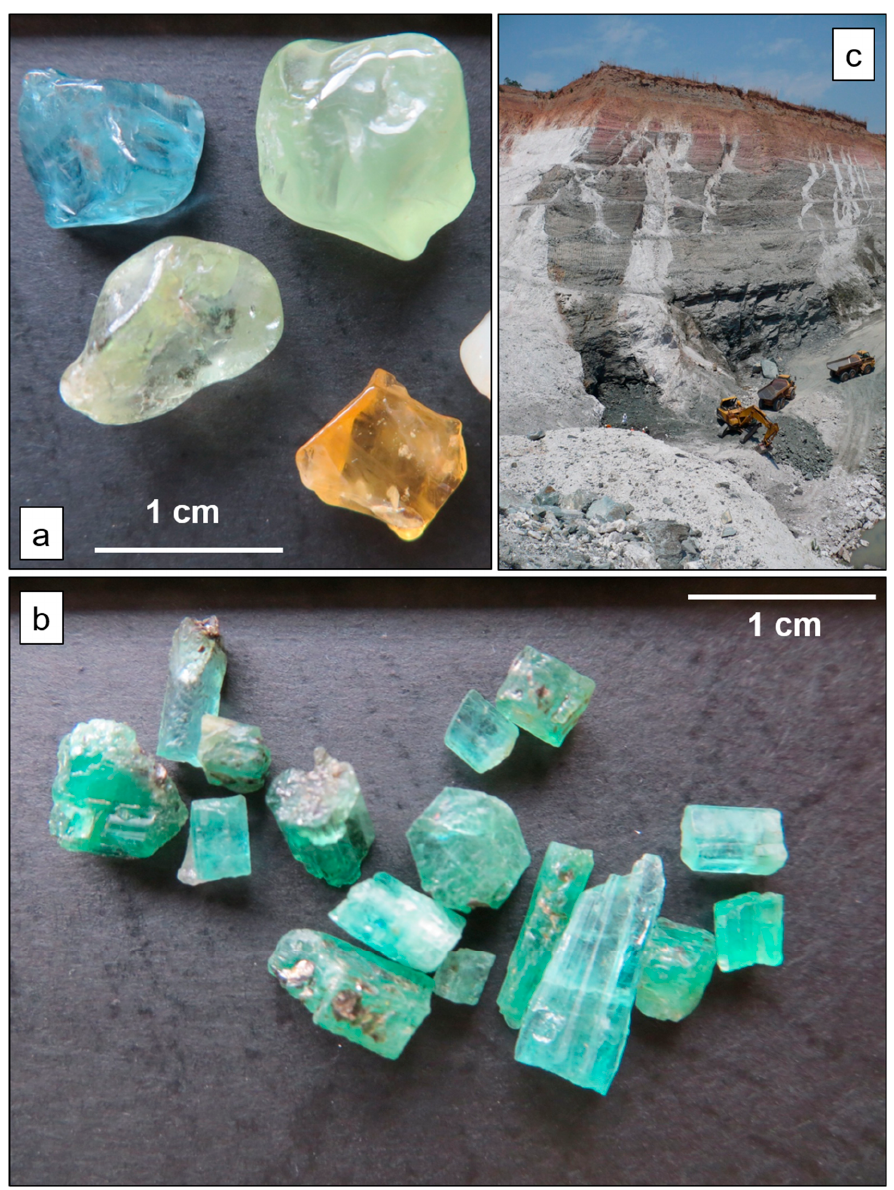
Figure 9. Varieties of beryl from different placer deposits. ( a ) Aquamarine and multicolored beryl from alluvial (fluvial) deposits in Tanzania. ( b ) Emerald fragments at the most proximal site to the current open pit. ( c ) Schist-hosted pegmatite related emerald deposit in Zambia. The chlorite-talc schists (metabasic rocks are overlain by muscovite-biotite schists. The emerald deposit gradually passes into the regolith forming the topstratum (residual placer) (Photograph: T.